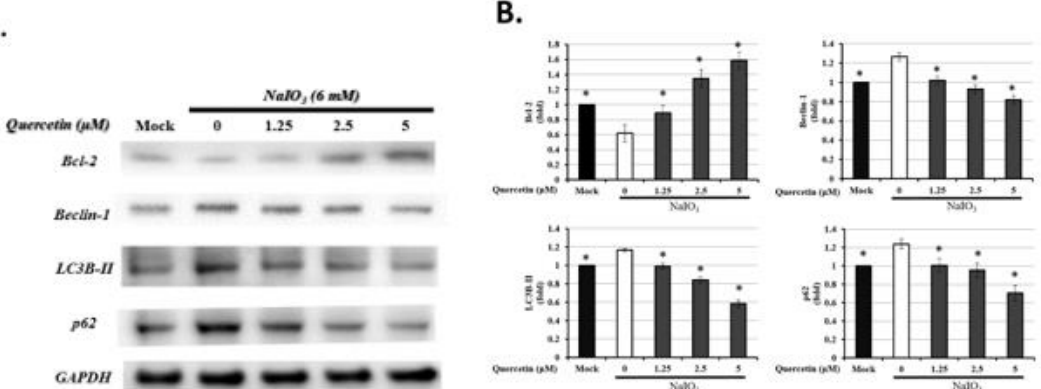
Figure 7. Quercetin affected the proteins related to autophagy in NaIO 3 -treated ARPE19 cells. ARPE-19 cells were either untreated (mock) or treated with 0, 1.25, 2.5, or 5 µ M quercetin followed by NaIO 3 (6 mM). ( A ) Total protein from the ARPE-19 cells was extracted for the measurement of Bcl-2, beclin-1, LC3B, and p62 expressions using Western blot analysis. The quantified expressions of ( B ) Bcl-2, beclin-1, LC3B, and p62 as mean ± SD ( n = 3, 3 individual set experiments of groups). Data were normalized to GAPDH. * p values ≤0.05 were considered statistically significant.